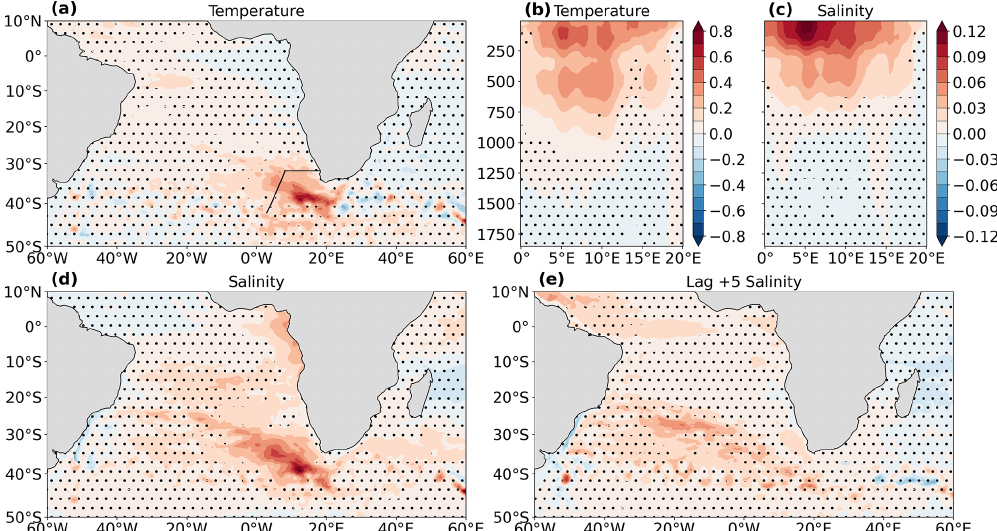
Figure 16. Composites of high Agulhas leakage periods for FixGHG: anomalies with respect to the 2014–2094 mean of potential temper- ature ( a ; ◦ C) and practical salinity at lag 0 years (d) and + 5 years (e) averaged over the upper 1000m of the ocean and depth profiles of potential temperature (b) and practical salinity (c) anomalies between 0 and 20 ◦ E at 35 ◦ S. The fields are low-pass-filtered to retain only variations with a period above 5 years and detrended by removing a linear trend. The stippling masks anomalies that are not significantly different from the time mean according to the Monte Carlo method (see text for details). The line in panel (a) marks the Good Hope section used in calculating the Agulhas